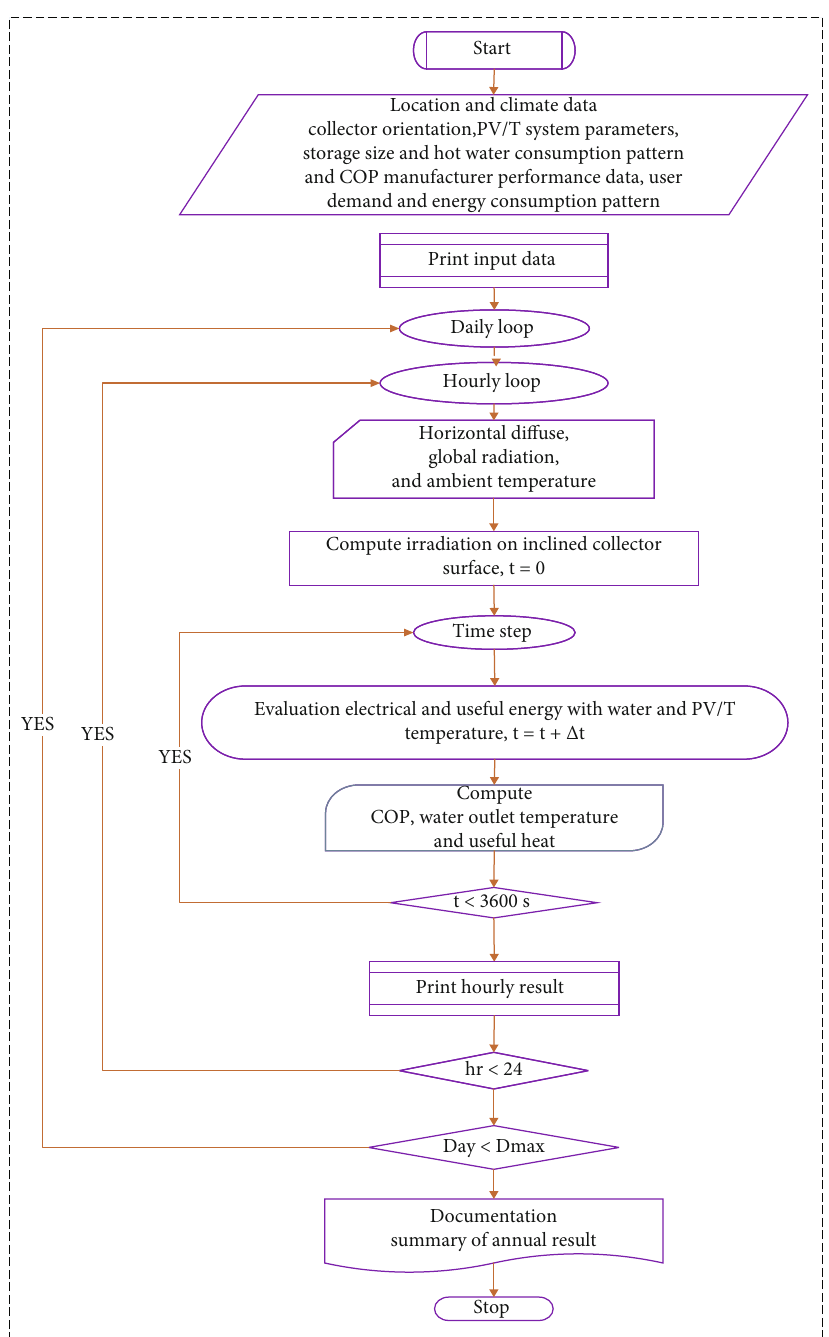
Figure 2: Hybrid PV/T heat pump system